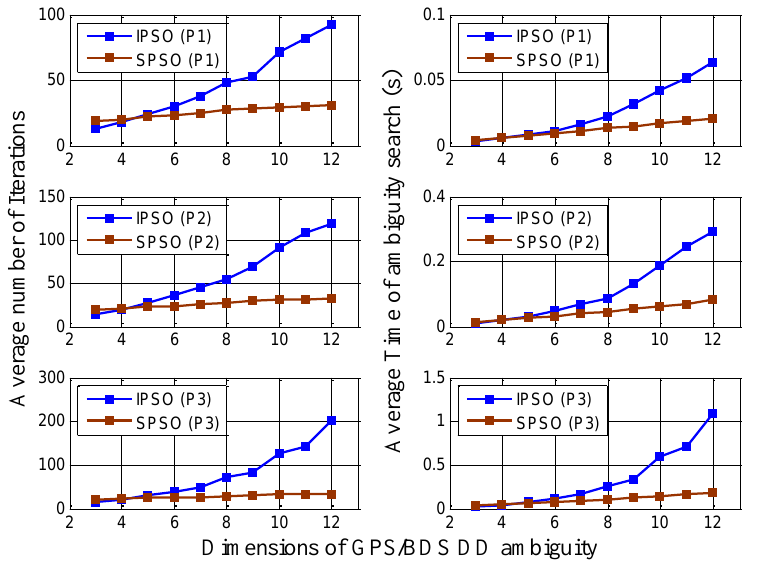
Figure 5. Average number of iterations and search time with various DD ambiguity dimensions for IPSO/standard PSO algorithm (SPSO)–AR under Scheme #1. GPS: Global Positioning System; BDS: BeiDou Navigation Satellite System.